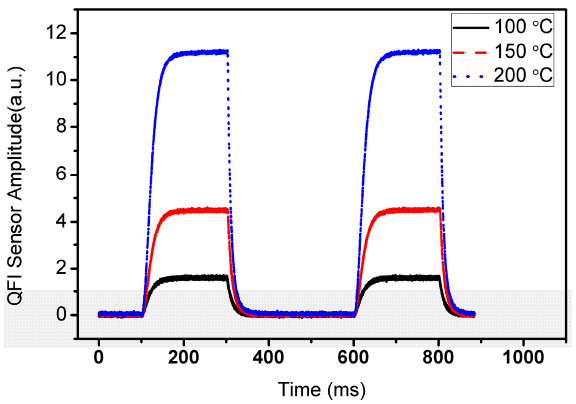
Figure 5. Heat-up and cool-down times as measured at 100 C, 150 C, and 200 C average active area temperature.